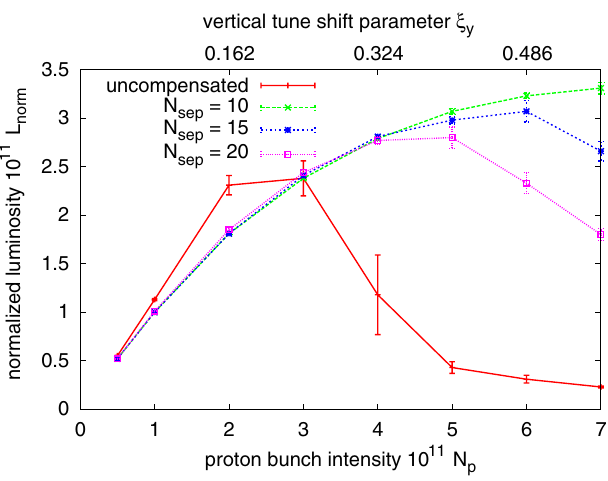
FIG. 11. (Color) Maximum achieved normalized luminosity L for three different numbers of FODO cells N norm the IP and the electron lens. The uncompensated case (no electron lens) is shown for